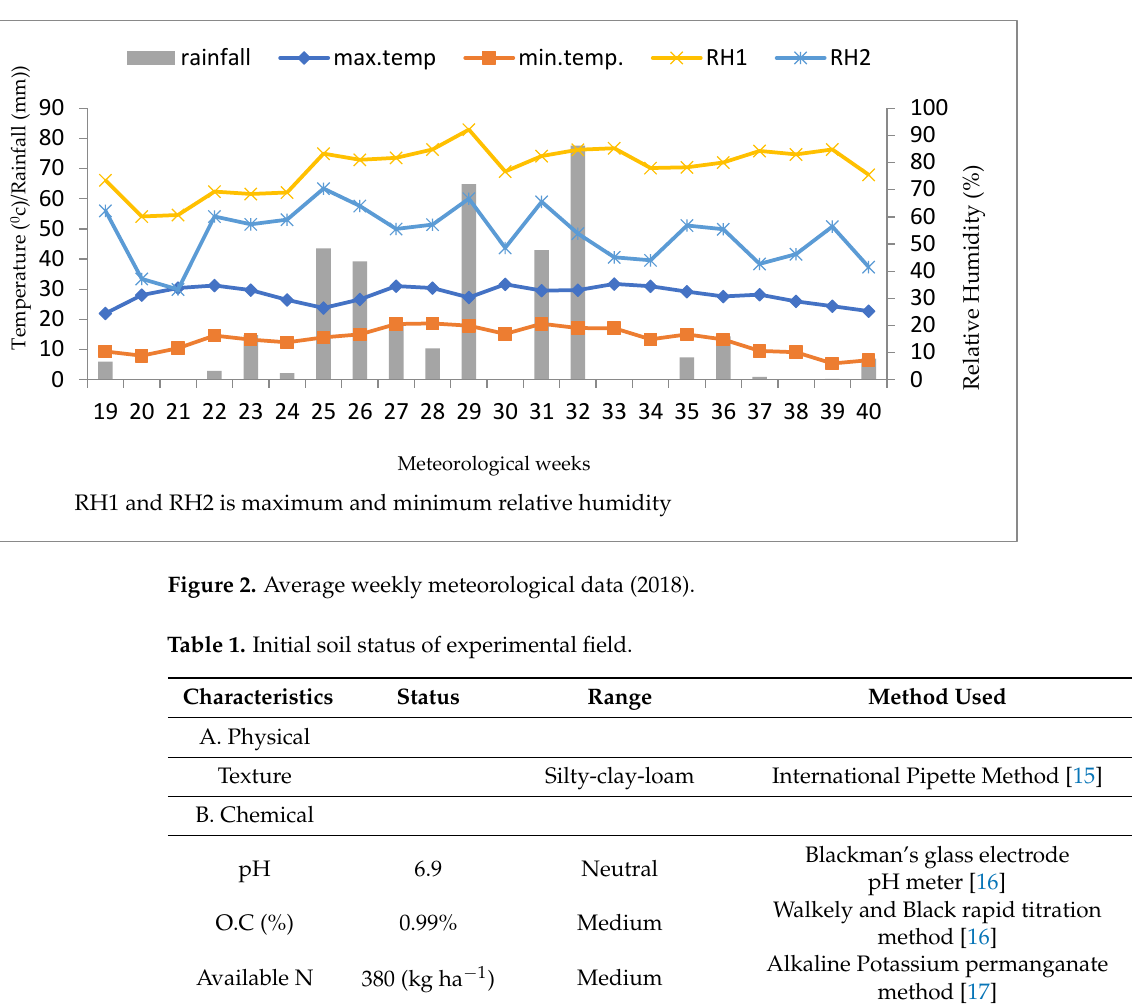
Figure 1. Average weekly meteorological data (2017).